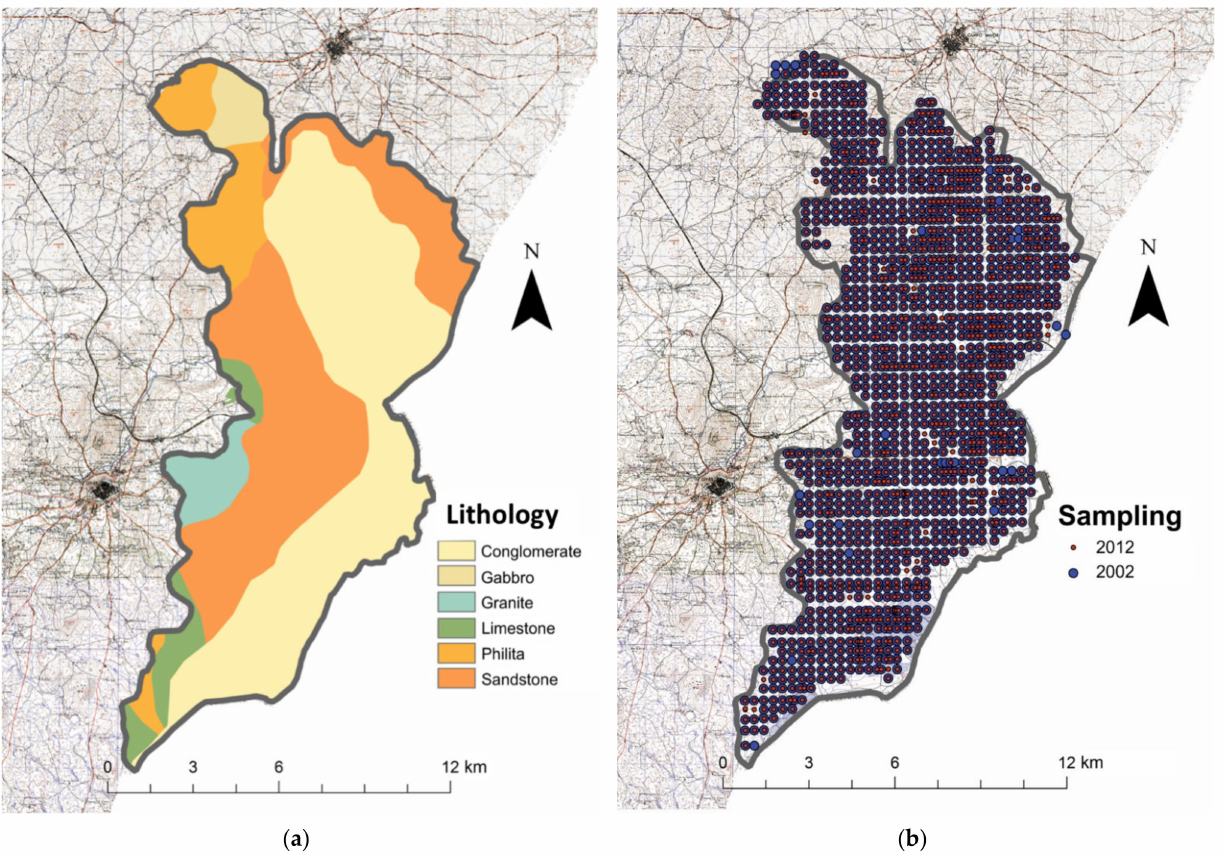
Figure 1. Study area ( a ) lithology and ( b ) sampled